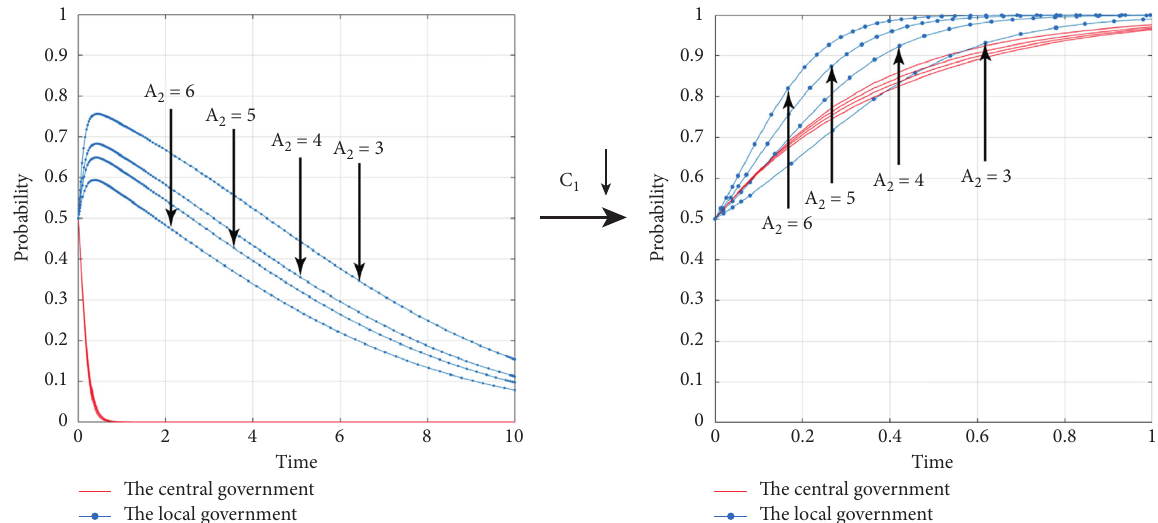
Figure 3: Evolution trajectory of the game behavior between the central government and the local government under different punishment